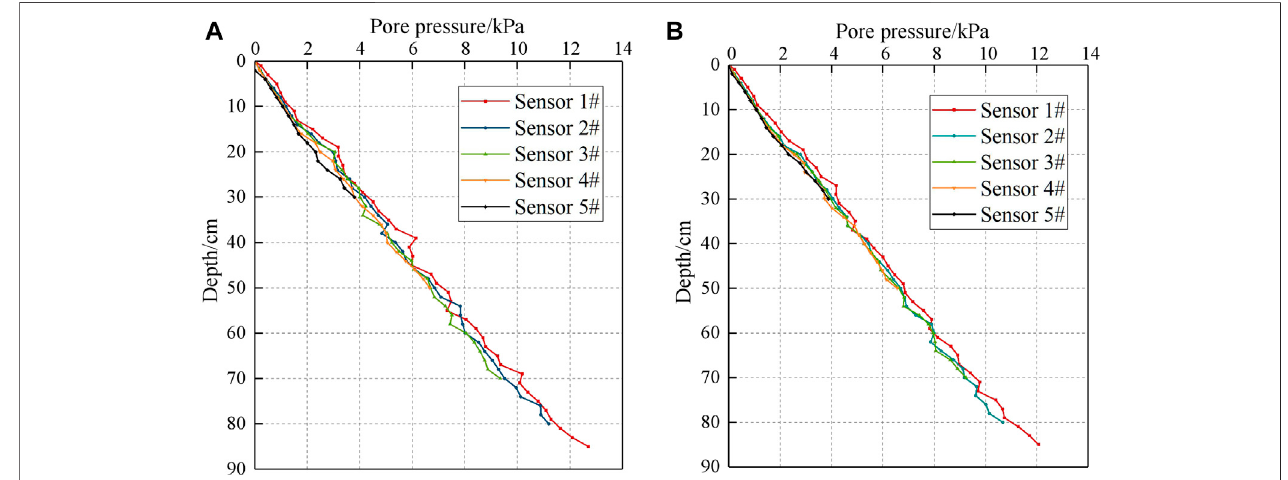
FIGURE 6 | Pore pressure curves at the pile surface with depth: (A) TP1 and (B) TP2.